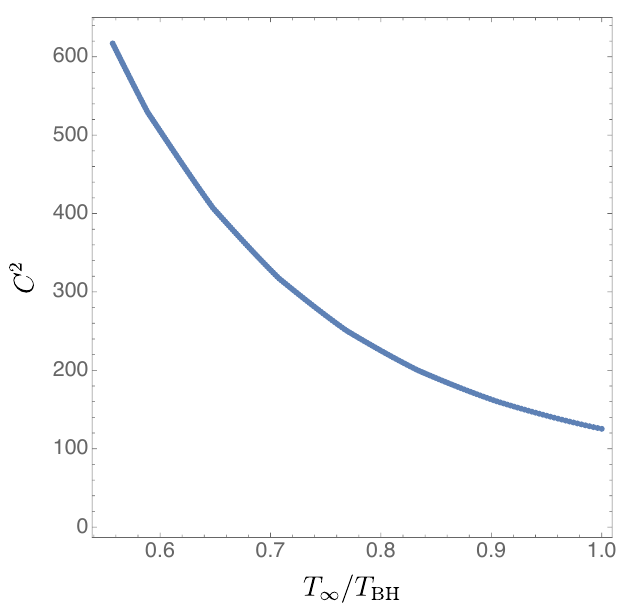
(cid:12) (cid:12) Figure 7 . C 2 (cid:17) max C (cid:12) C abcd C abcd (cid:12) , where C stands for domain of outer communications, as a function of T 1 =T BH . We see no apparent divergent behaviour as we lower the temperature ratio T 1 =T BH